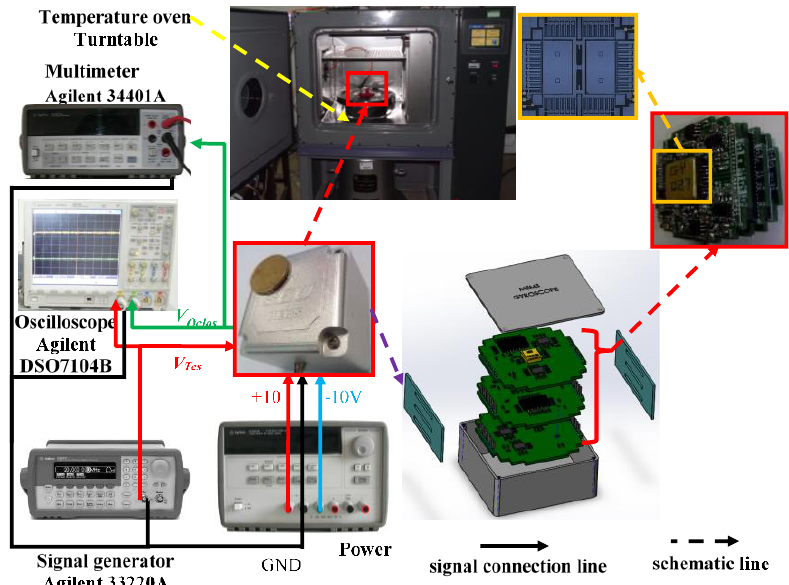
Figure 8. Gyroscope temperature test equipment.